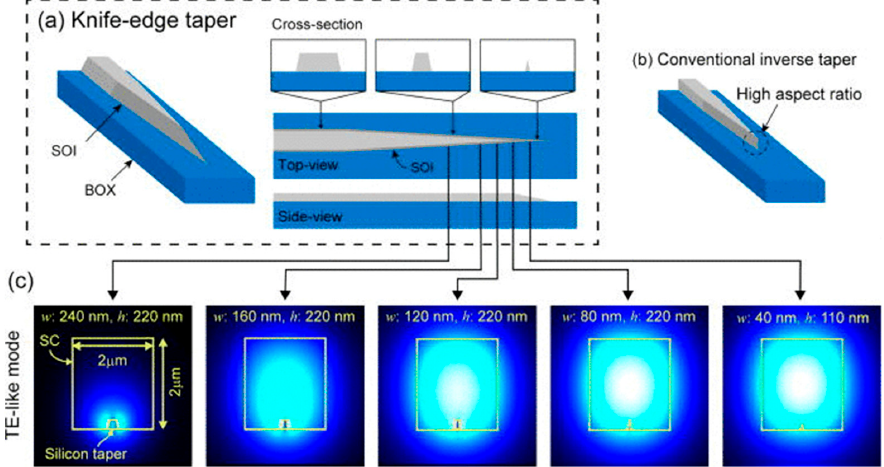
Figure 15. Schematics of ( a ) knife-edge taper; ( b ) conventional inverse taper; and ( c ) mode distribution inside the knife-edge taper for the TE mode at 1550 nm. Reproduced with permission from [99], Copyright AIP Publishing,